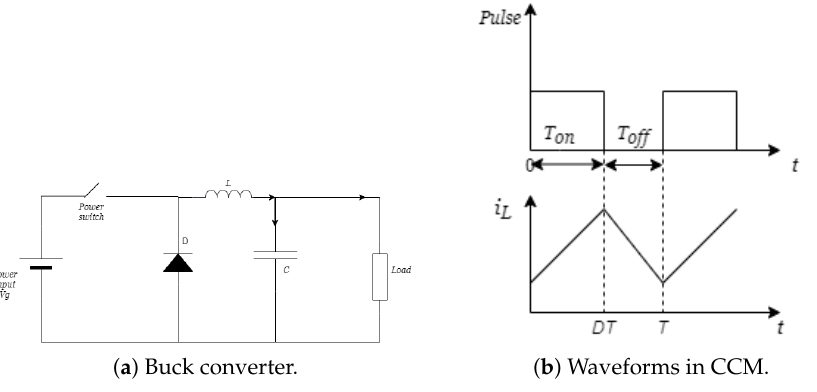
Figure 1. Buck converter and